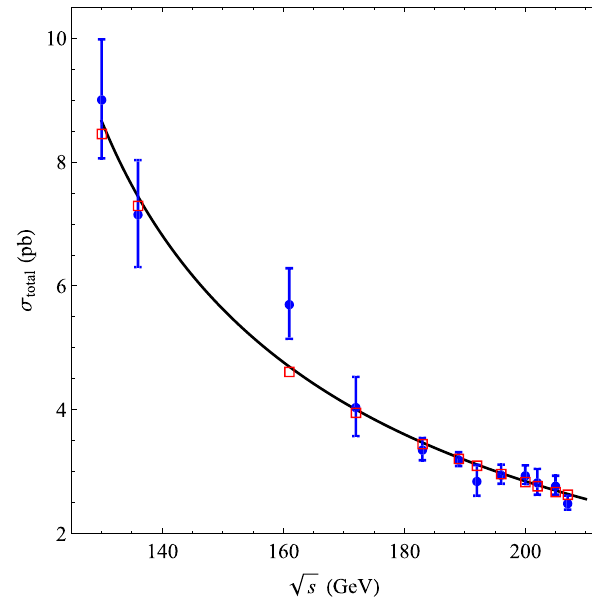
Fig. 2 The total cross-section of the process e − e + → τ − τ + as a √ s . The LEP-II data and the function of the center-of-mass energy ZFITTER predictions for the cross-sections are shown as dots with corresponding error bars and red empty squares, respectively [14] . The SM calculation performed using GRACE at the next-to-leading order is represented by the black solid line where a NP τ =